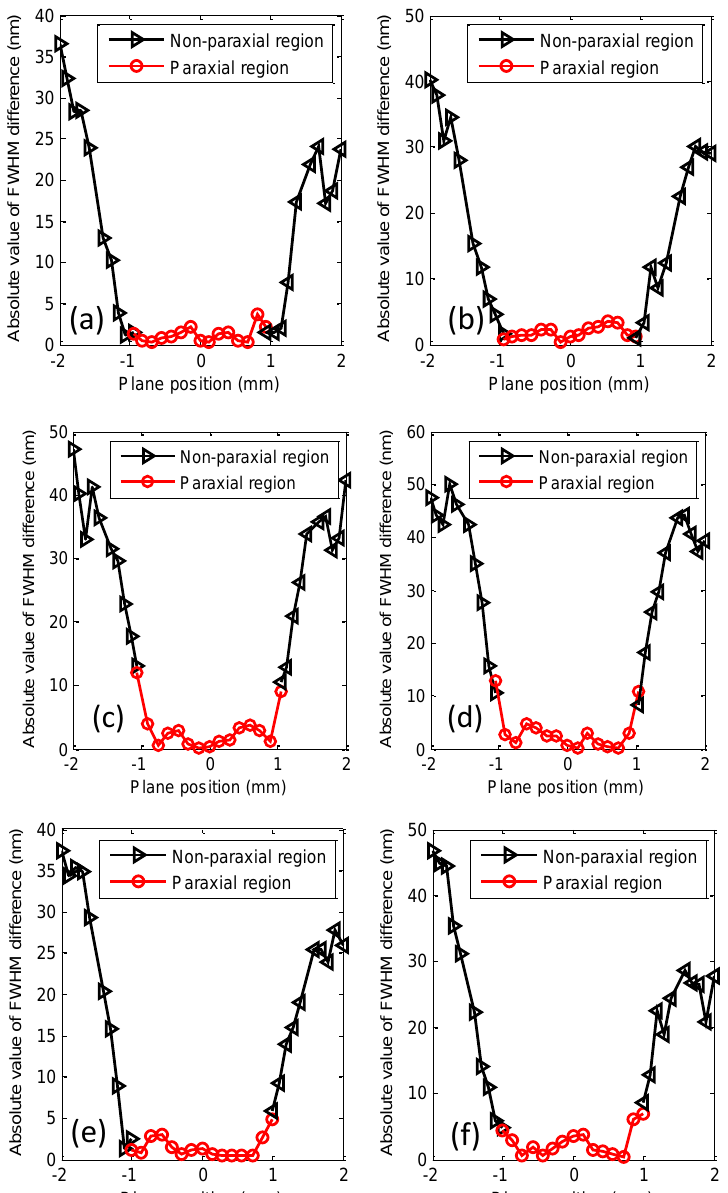
Figure 9. Full widths at half maximum (FWHM) differences between the measured FWHM and the calculated FWHM for standard 100 nm ( a , c , e ) and 200 nm ( b , d , f ) diameter nanoparticles: On the 0.5 µ m Z-axis position ( a , b ); on the original Z-axis position ( c , d ); and on the –0.5 µ m Z-axis position ( e , f ).